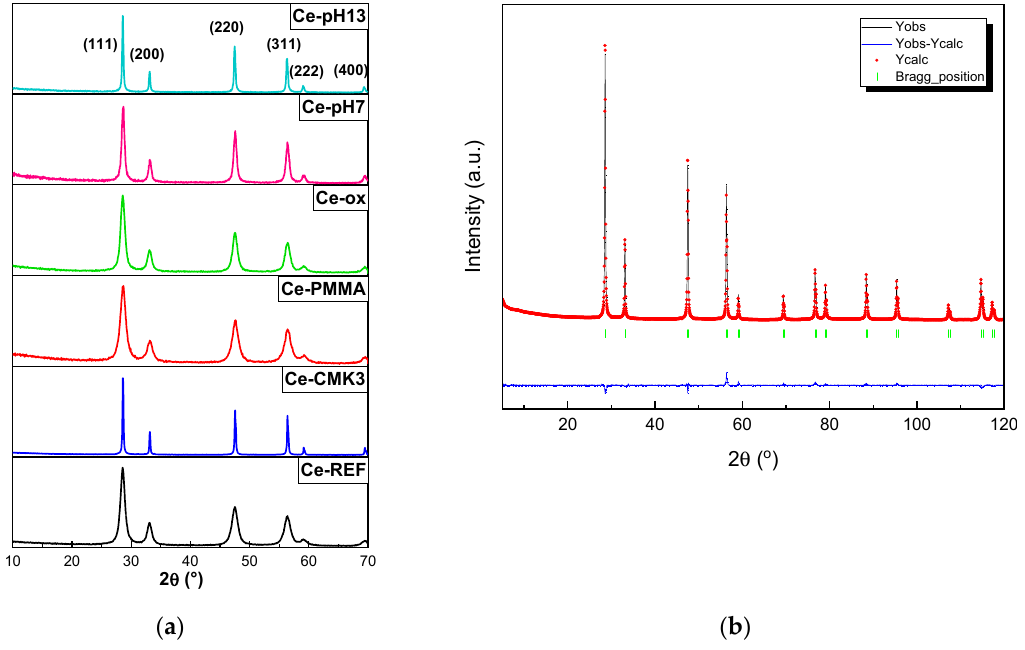
Figure 1. ( a ) XRD diffraction patters for prepared the ceria materials. The indexation refers to CeO 2 fluorite-type (PDF 01-078-0694); ( b ) Rietveld profiles and R-factors for the Ce-CMK3 sample.